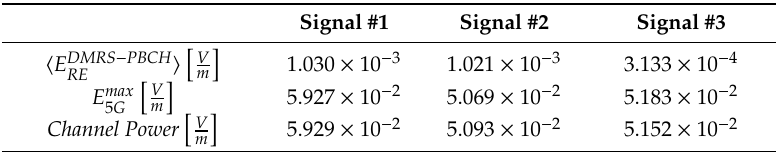
Table 3. Comparison between the channel power and the instant maximum EMF level extrapolated by Equations (4) and